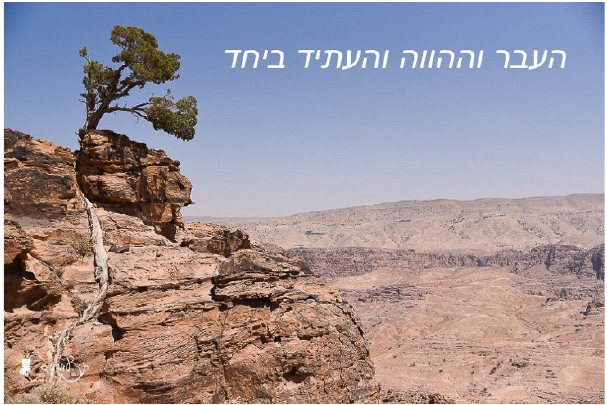
Figure 3. Yossi’s choice of photograph and title: “The past, the present and the future, together”. Reproduced with permission from Yehudit Liberman.